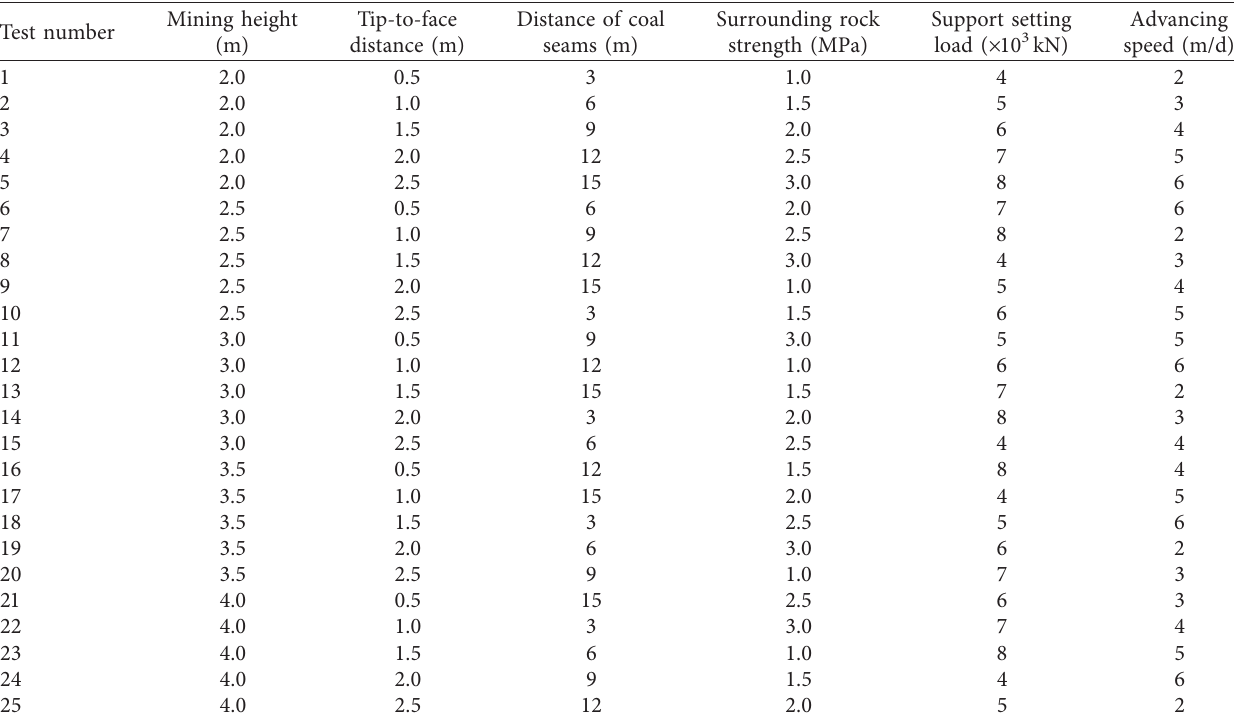
Table 4: Numerical simulation